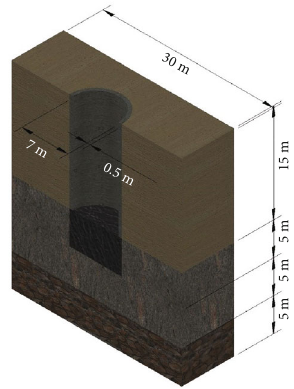
Figure 4: Modeling theory Table 1: Physical and mechanical parameters.